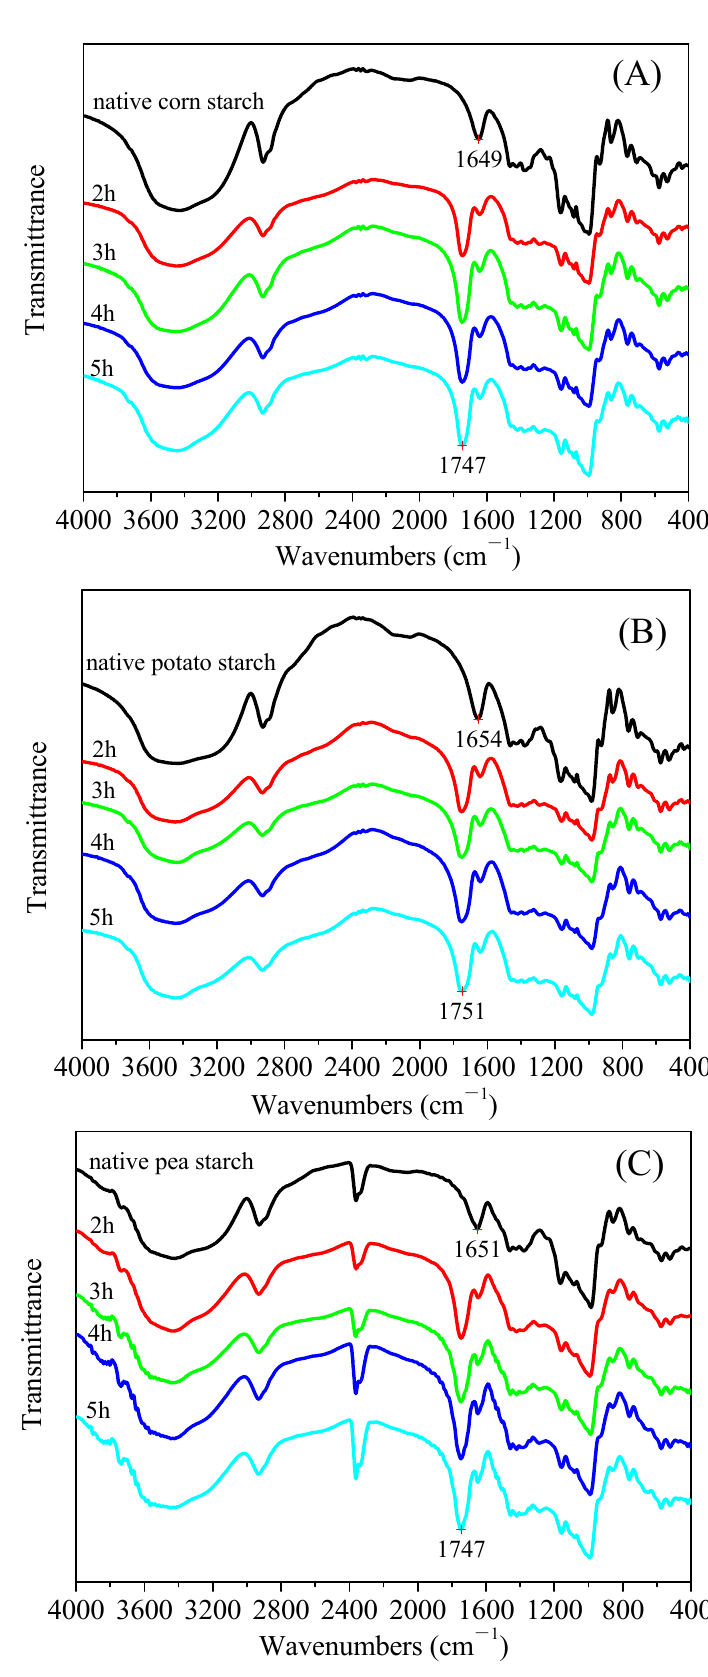
Figure 4. Fourier Transform Infrared Spectroscopy spectra of malate starch samples: ( A ) Corn starch, ( B ) Potato starch, ( C ) Pea starch.